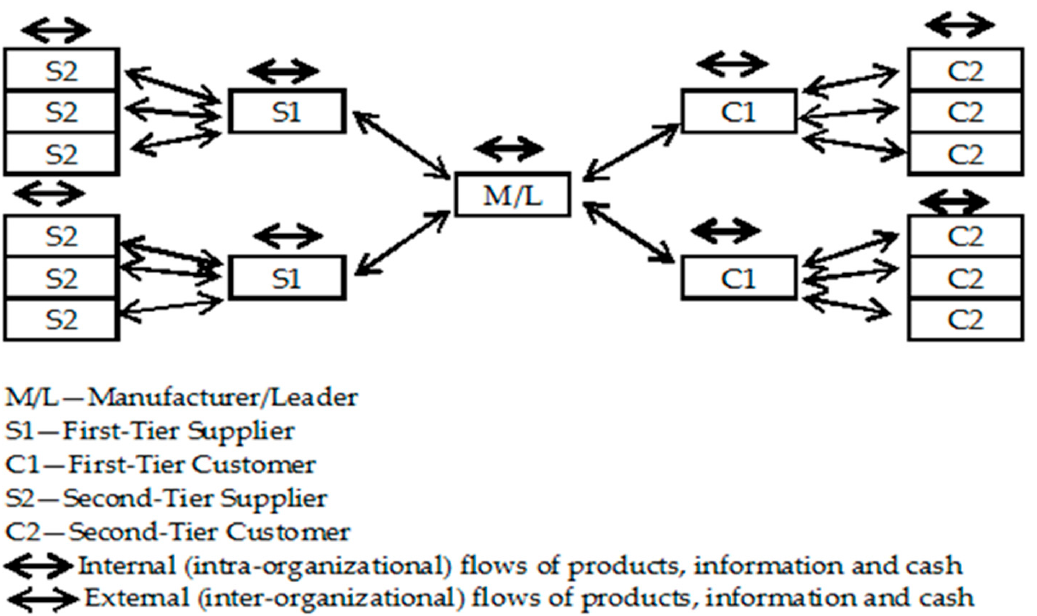
Figure 1. Supply chain visualisation.